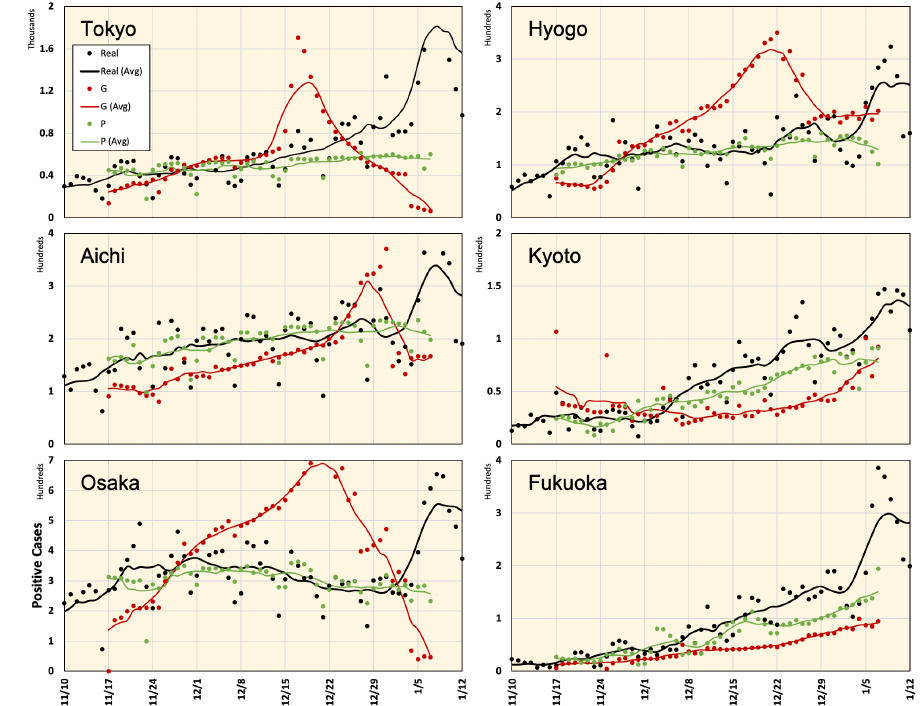
Figure 8. Real and estimated number of positive cases using Google Cloud forecast (G) and the proposed framework (P) for different regions in Japan. Values are computed as the average of the seven periods shown in Figures 6 and 7, and the curves demonstrate a 7-day